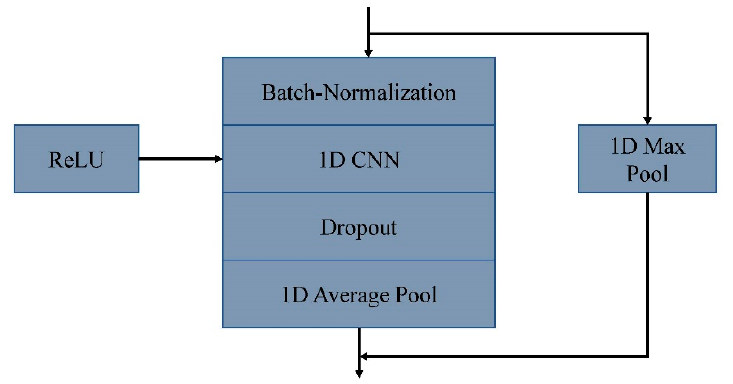
Figure 8. A convolution block based on shortcut connections.